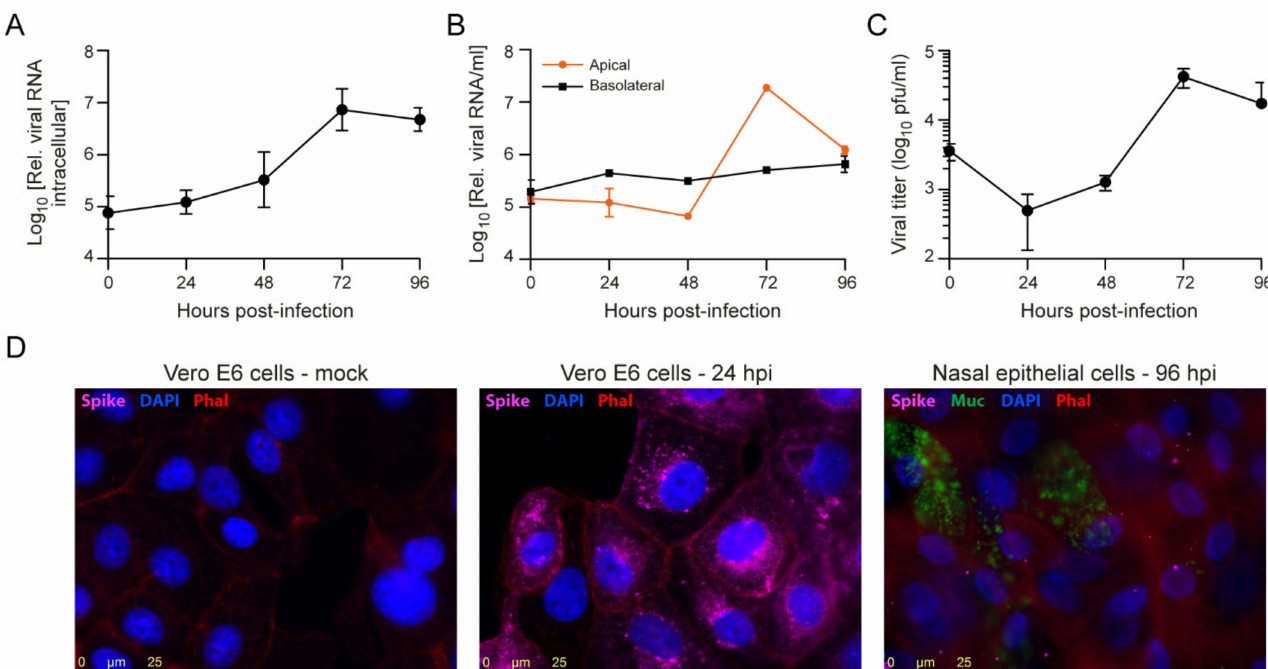
Figure 4. SARS-CoV-2 infection of primary nasal epithelial cells. Primary nasal epithelial cells, cultured on an air-liquid interface, were infected with SARS-CoV-2 (BavPat1 isolate) at an MOI of 10. At the indicated time points, cells were harvested and viral RNA from ( A ) cells or ( B ) apical and basolateral compartment supernatants was quantified by RT-qPCR. Intracellular viral RNA levels were normalized to the human β -actin housekeeping gene. Error bars indicate SD (n = 2). ( C ) Infectious viral titers from apical supernatants corresponding to the indicated time points were quantified by plaque assay. Error bars indicate SD (n = 2). ( D ) Immunofluorescence staining of mock (left panel), SARS-CoV-2 infected Vero E6 cells fixed at 24 hpi (MOI = 0.01; middle panel) or SARS-CoV-2 infected primary nasal epithelial cells fixed at 96 hpi (MOI = 10; right panel). The presence of SARS-CoV-2 Spike protein subunit S1 (pink) was assessed in cells stained with DAPI (nucleus, blue) and phalloidin (F-actin, red). Nasal epithelial cells were additionally stained with anti-Muc5AC antibodies (Muc, goblet cells, green). Bar represents 25 µ